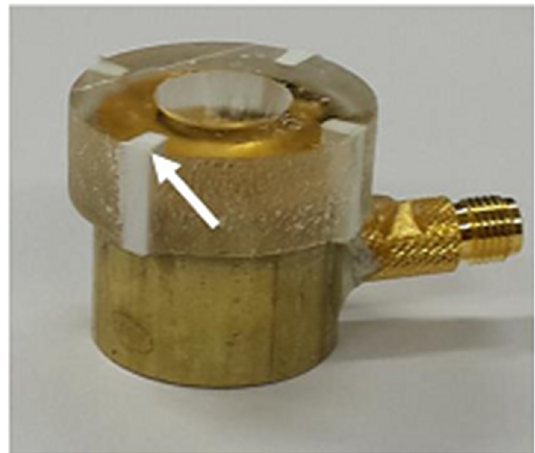
Figure 7. Photograph of the finished double-focused transducer. The white arrow indicates the part of an acoustic lens molder remaining after lapping. The lens molder was used to secure the maximum thickness of the lens, i.e., 6.5 mm.